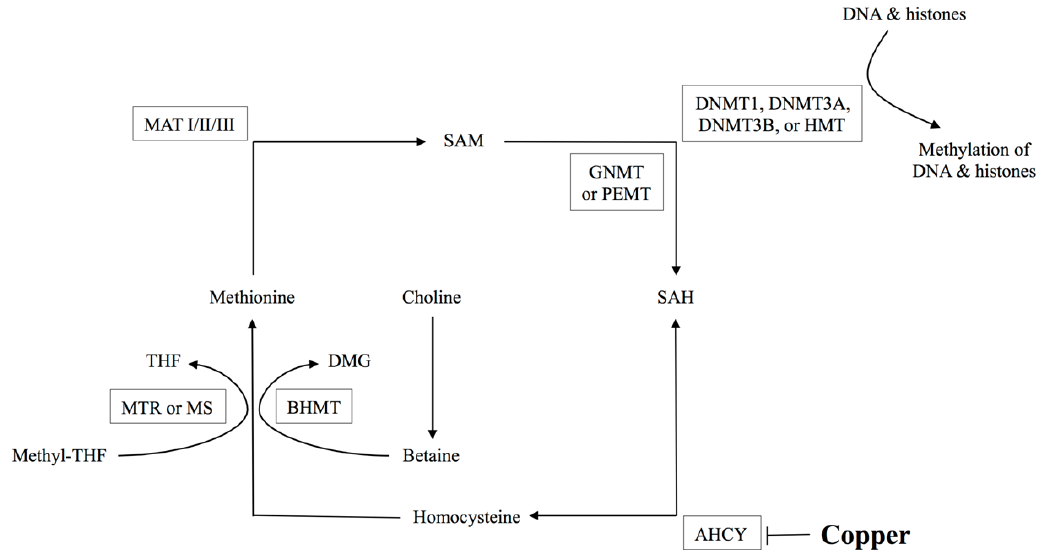
Figure 1. Methionine metabolism. S-adenosylmethionine (SAM) is the principal methyl donor for DNA and histone methylation reactions, whereas S -adenosylhomocysteine (SAH) inhibits all SAM-dependent methylation reactions. S -adenosylhomocysteinase (AHCY) is the bi-directional enzyme that hydrolyzes SAH to generate homocysteine. Methionine synthase (MTR or MS) remethylates homocysteine to form methionine that is in turn converted to SAM via the enzyme methionine adenosyltransferase (isoenzymes MATI/II/III). Homocysteine can also be remethylated to methionine via the betaine homocysteine Dimethylglycine (DMG) is a byproduct of the BHMT catalyzed reaction and is also a potent inhibitor of BHMT. Tetrahydrofolate (THF); DNA methyltransferase (DNMT); histone methyltransferase (HMT); glycine N -methyltransferase (GNMT); phosphatidylethanolamine N -methyltransferase (PEMT); DNMTs, GNMT, and PEMT are major consumers of SAM in the liver